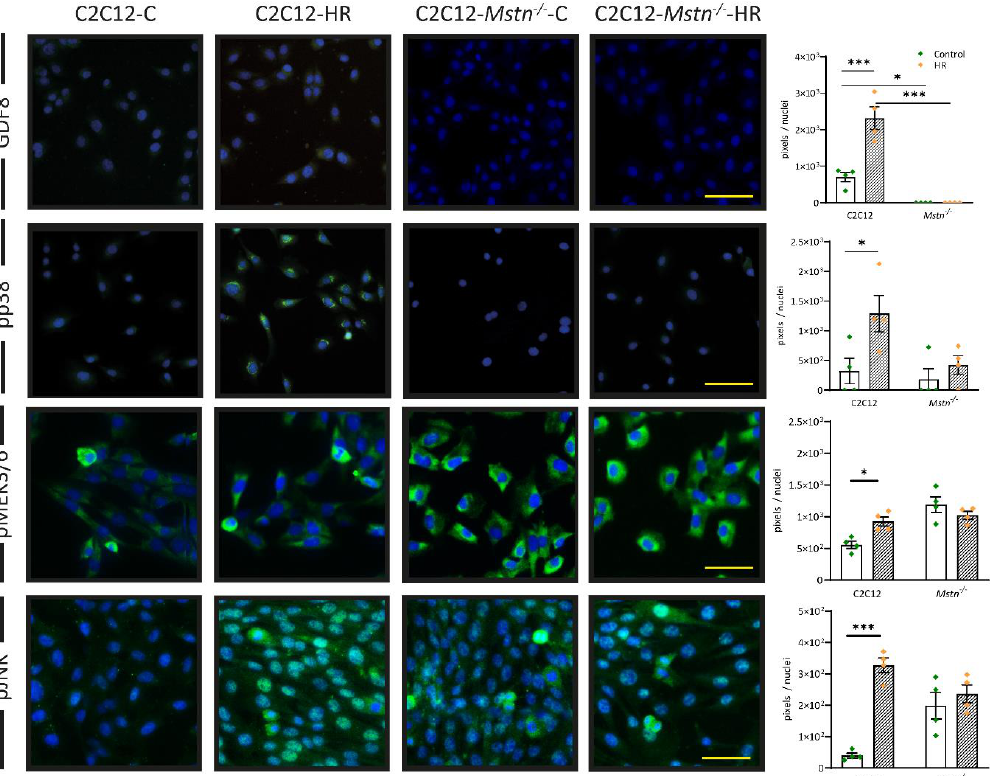
Figure 4. Intracellular signaling via the myostatin (GDF8)–pp38 axis, which sidesteps regulation via pMEK3/6 in C2C12- Mstn −/− cells. Immunofluorescence analysis of the myostatin–pp38 MAPK pathway, pMEK3/6, and pJNK. C, control cells incubated under normoxia. HR, cells incubated under hypoxic conditions for 4 h followed by normoxia for 15 min. For each graph, four independent experiments per group were conducted. Scale bar = 50 µm. Results are shown as means ± SEM. Cell nuclei were counterstained with DAPI. p -value: * < 0.05, *** < 0.001; ANOVA followed by a multiple test comparison via Tukey’s post-hoc test (homoscedasticity) or Brown–Forsythe and Welch ANOVA followed by Dunnett’s T3 post-hoc test (heteroscedasticity).